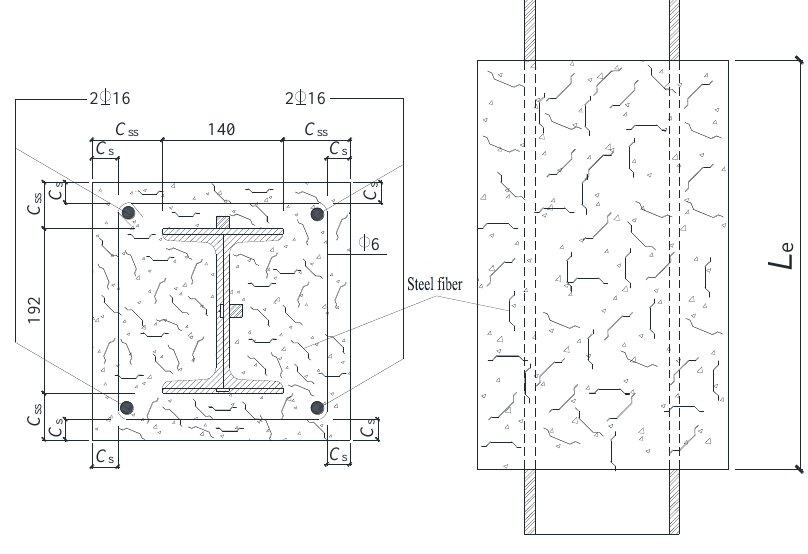
Figure 2. Test specimen size.